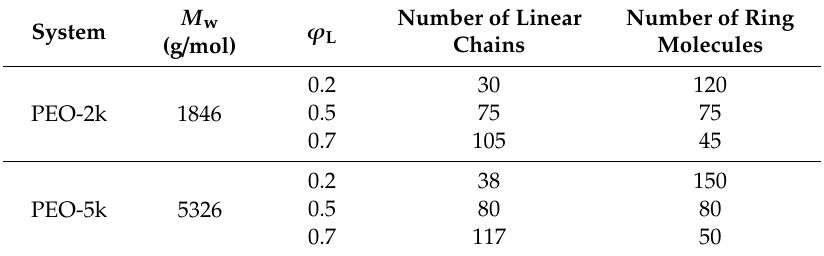
Table 1. Some technical details (molecular weight of ring and linear chains, molar fraction of linear chains, number of linear chains in the simulation cell, number of rings in the simulation cell) concerning the ring-linear PEO blends studied.